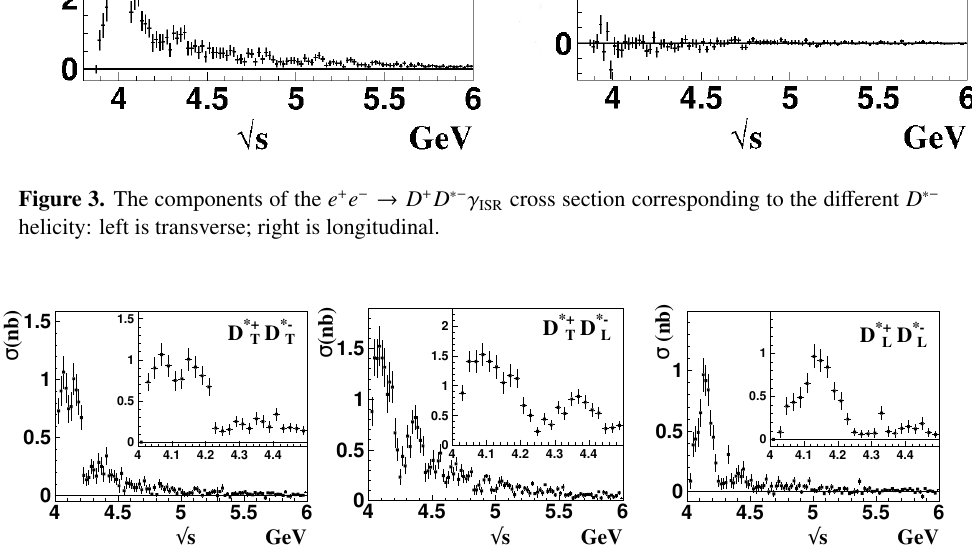
Figure 4. The components of the e + e − D ∗ D ∗ γ ISR cross section corresponding to the di ff erent D ∗± ’s → helicities. The insets show the zoomed spectrum near the threshold with a half-size bin width.